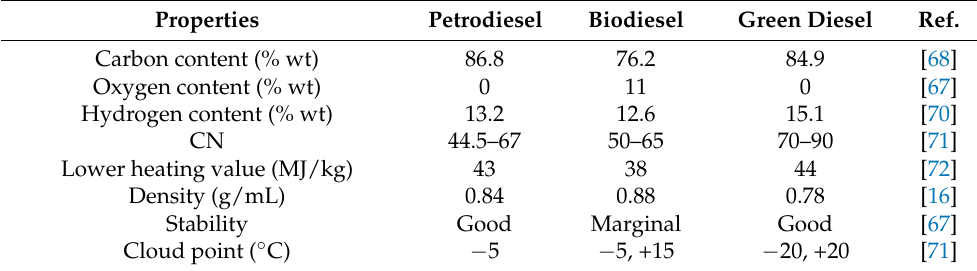
Table 1. A comparison of the physical properties of petrodiesel, biodiesel, and green diesel; data adapted from sources in the “Ref.”